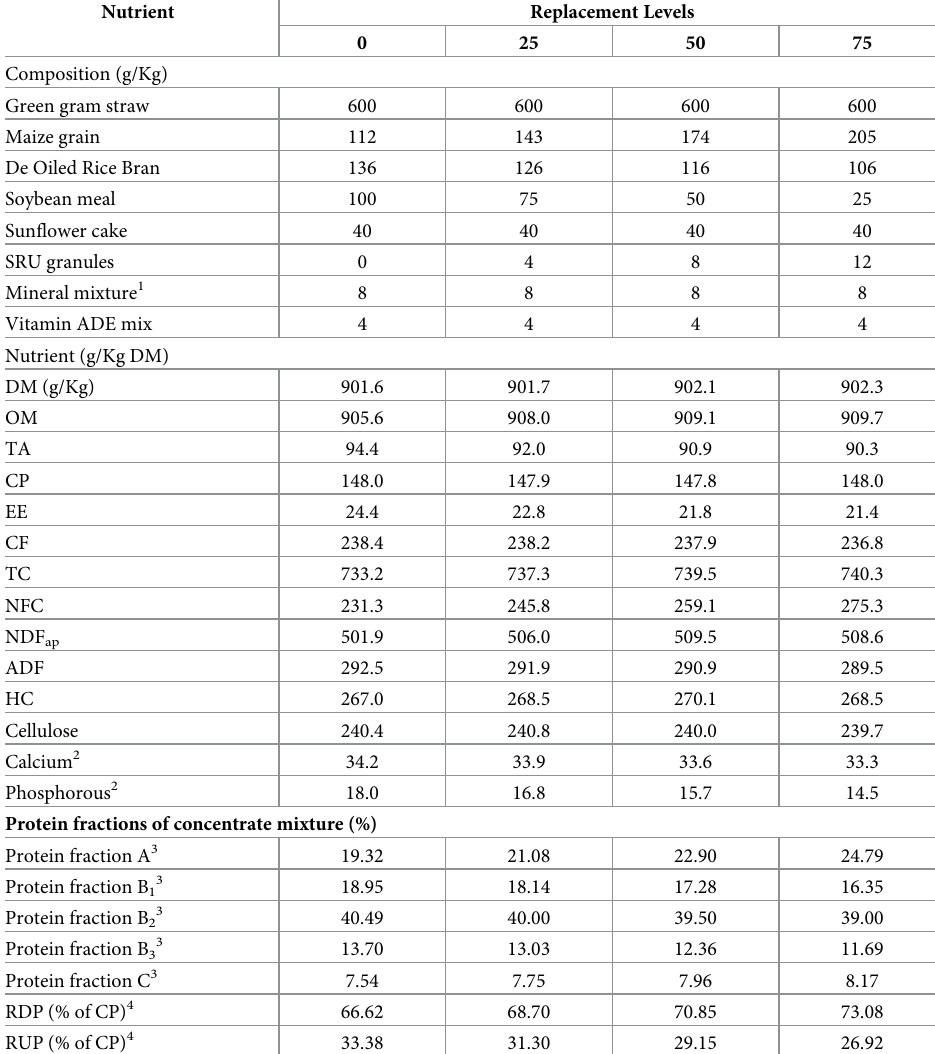
Table 1. Composition and analyzed nutrient of experimental total mixed